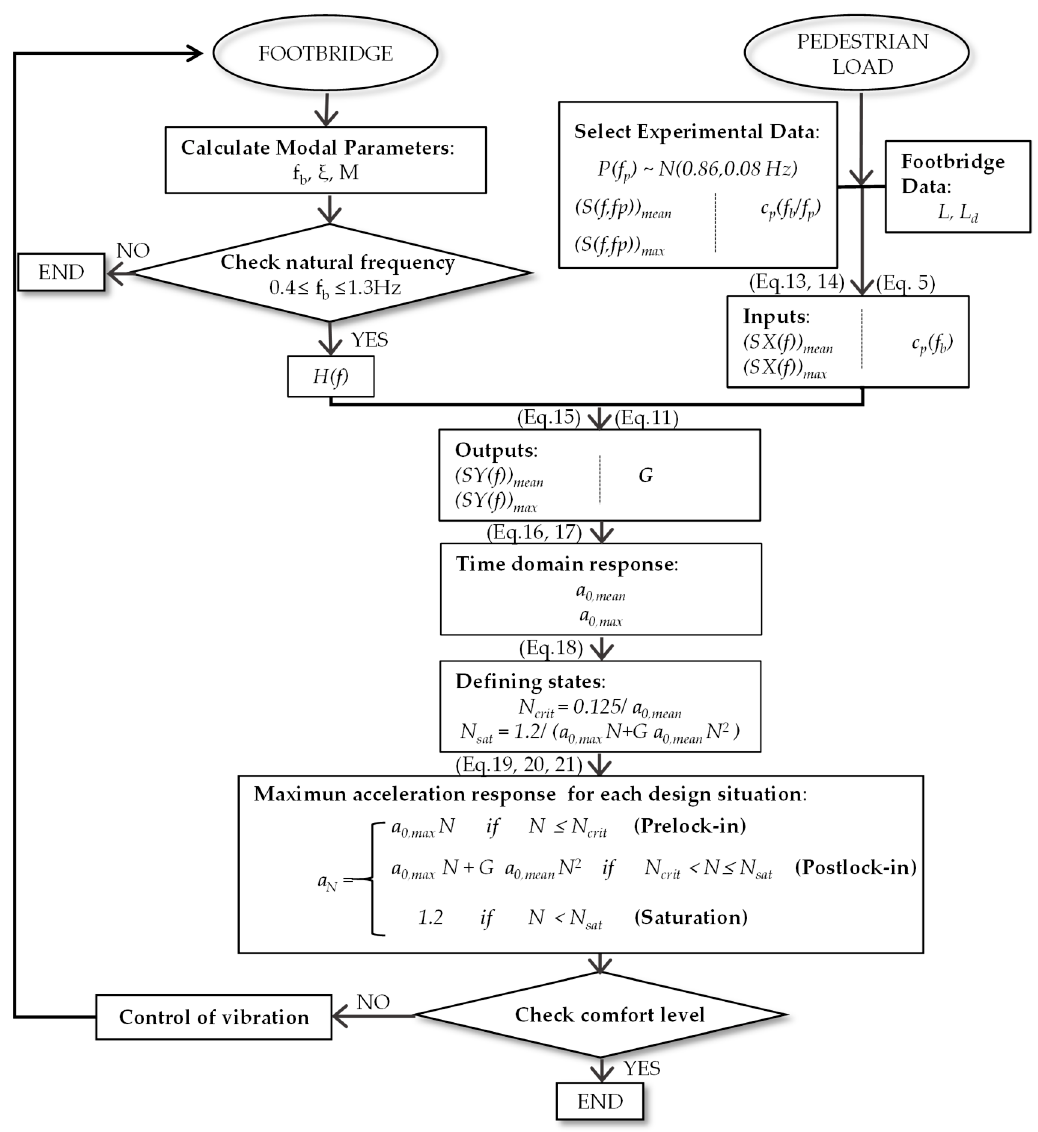
Figure 7. Flowchart for the application of the proposed formulation.